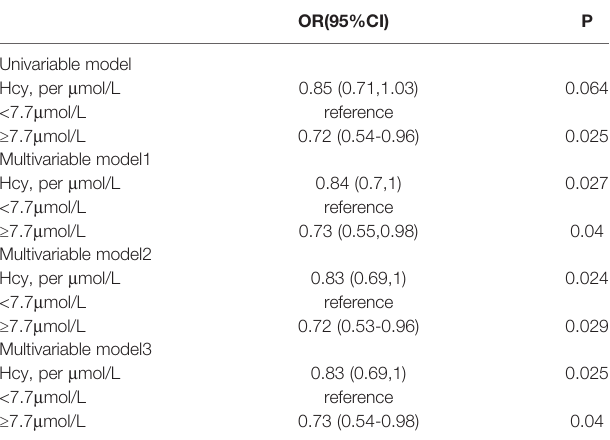
TABLE 2 | Odds ratio of Homocysteine (Hcy) for the risk of diabetic